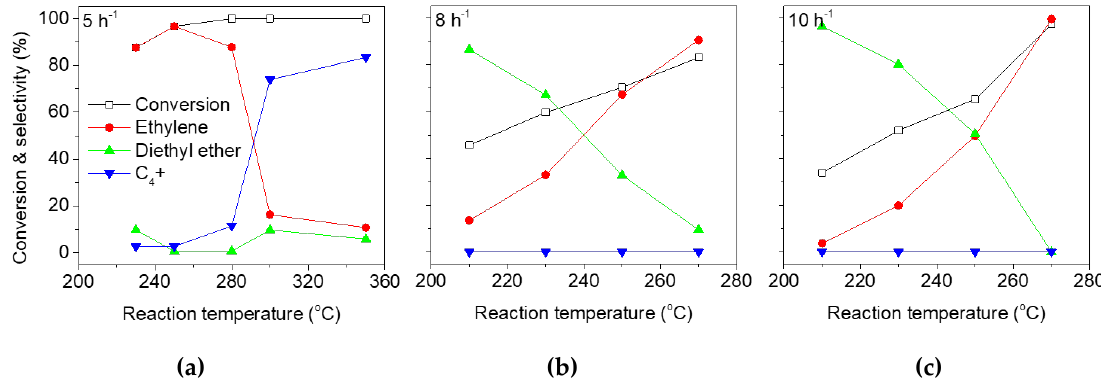
Figure 2. Etha nol conversion (□) and selectivities to ethylene (● ), diethyl ether ( ▲ ), and C 4 + compounds ( ▼ ) obtained after 20 h on stream as a function of reaction temperature in dehydration of bioethanol over 0.2 g of H-ZSM-5 (SiO 2 /Al 2 O 3 = 23) at 5 (left), 8 (middle), and 10 h -1 (right) WHSV.